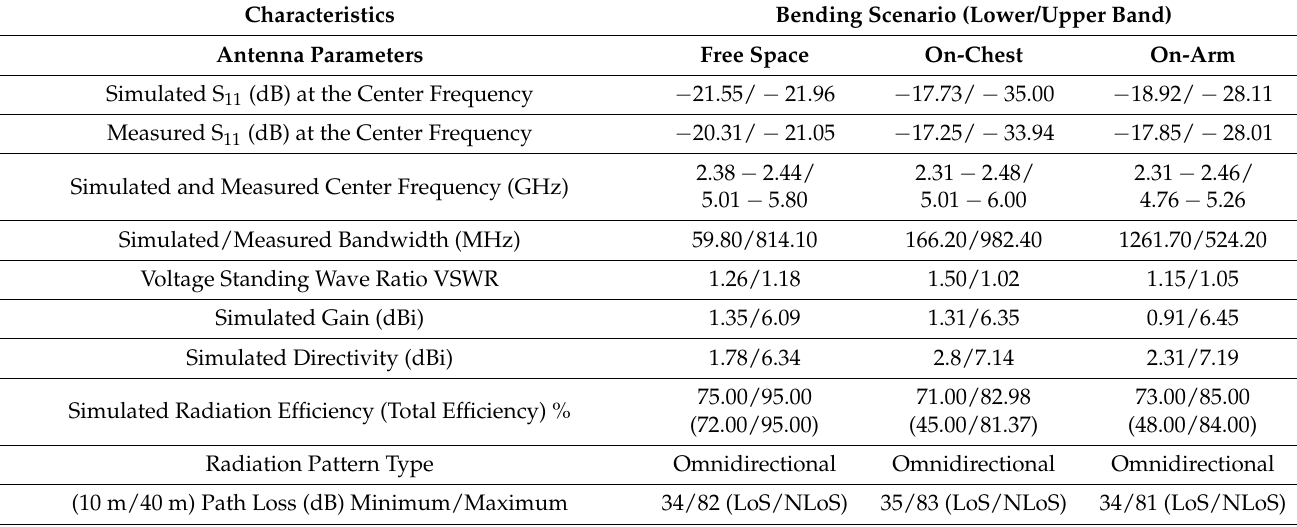
Table 6. Summary of the Design Performance Measured in Bending